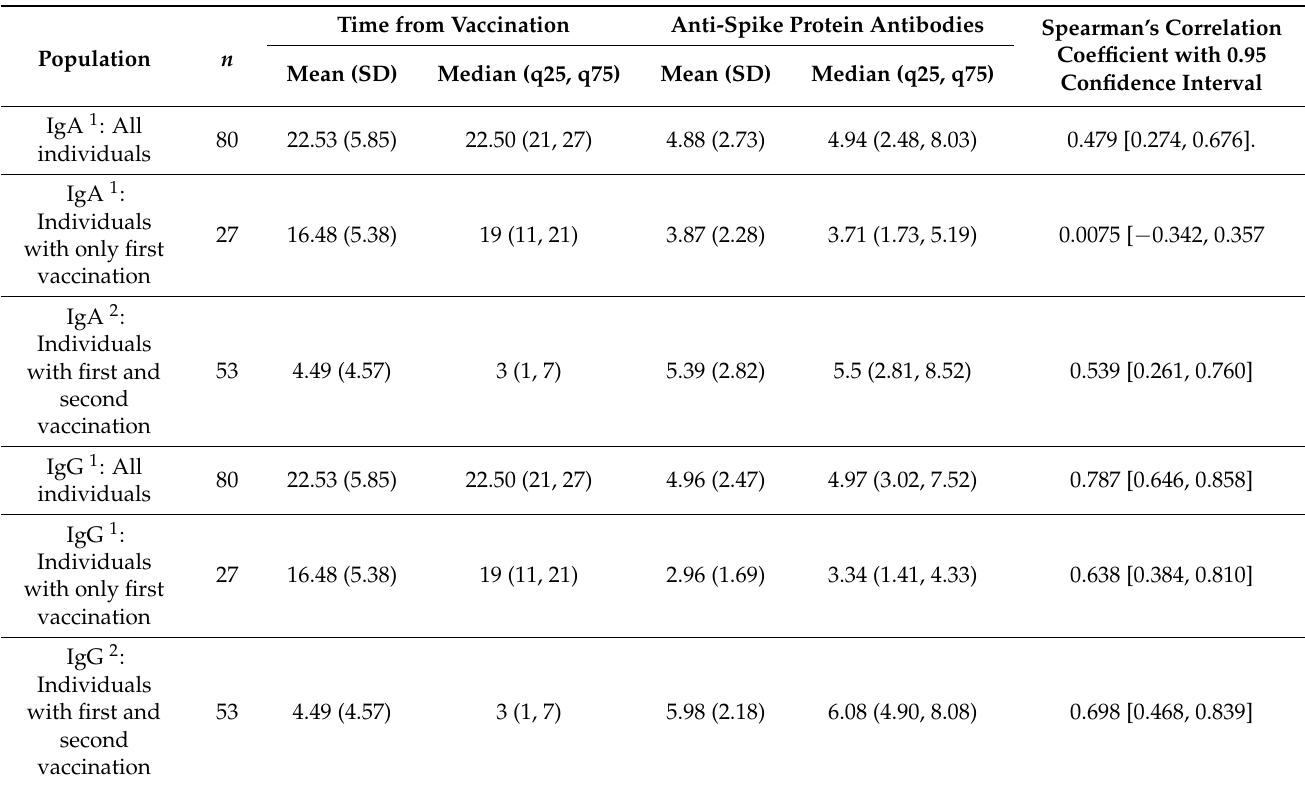
Table 1. Spearman’s correlation coefficient between the time from the first and second vaccination and the titers of the anti-spike protein antibodies. The p -values for the titers of the anti-spike protein antibodies and the time from first and second vaccination were 0.00003 and <0.0001, respectively.